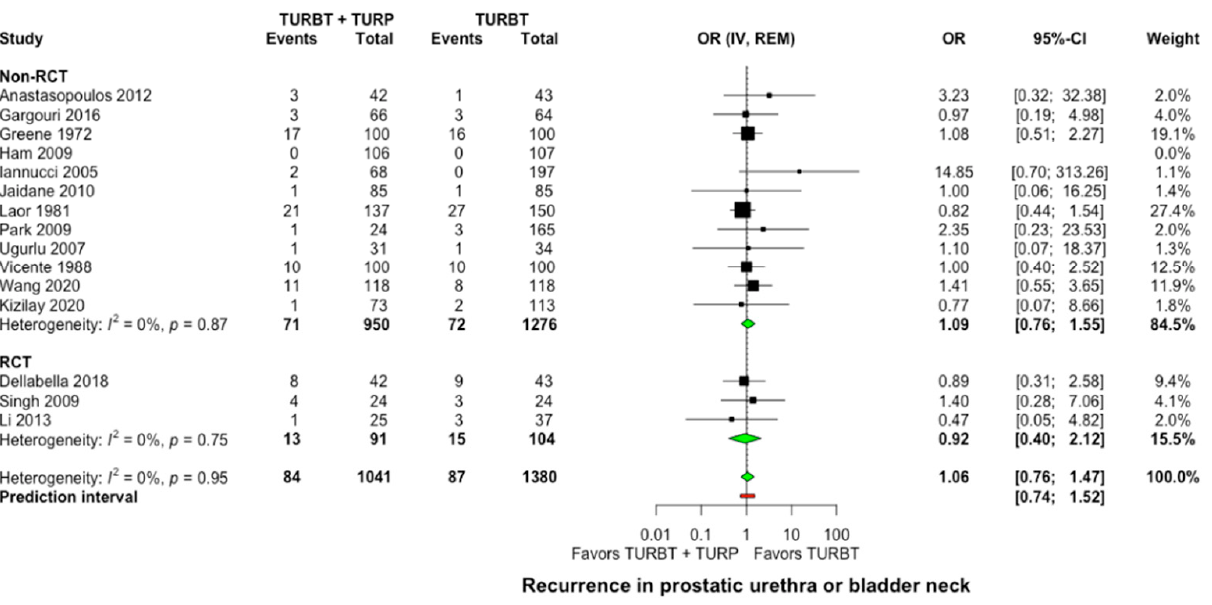
Figure 3. Forest plot comparing concomitant TURBT and TURP versus TURBT in terms of prostatic urethra and bladder neck recurrence. CI: confidence interval; IV: inverse variance; OR: odds rati ο ; RCT: randomized controlled trial; REM: random-effects model; TURBT: transurethral resection of bladder tumor; TURP: transurethral resection of prostate.